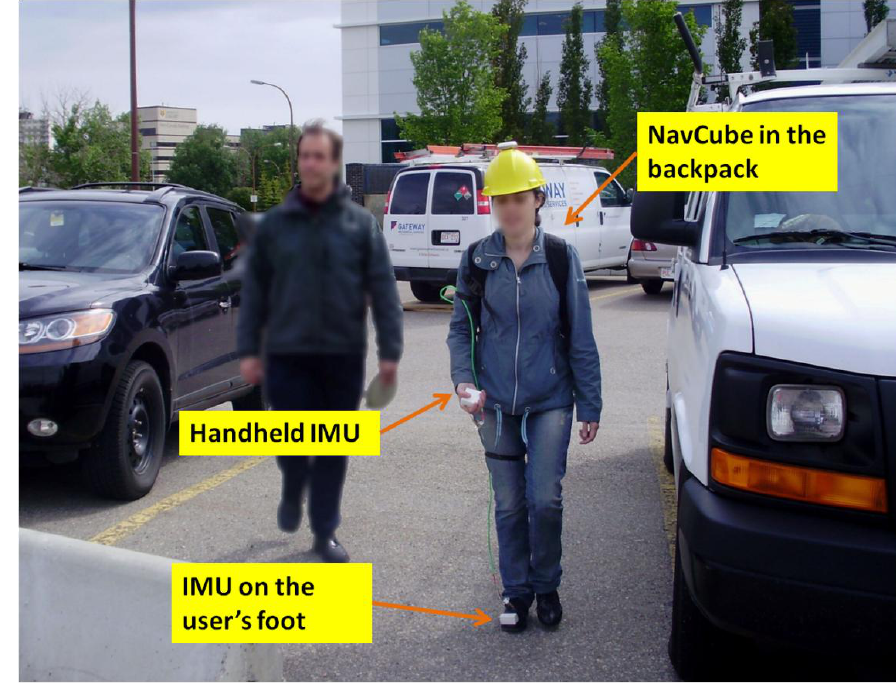
Figure 11. Handheld data collection setup. One IMU is located in the hand and the other one is rigidly attached to the foot. Data is recorded by the NavCube placed in the user’s backpack.